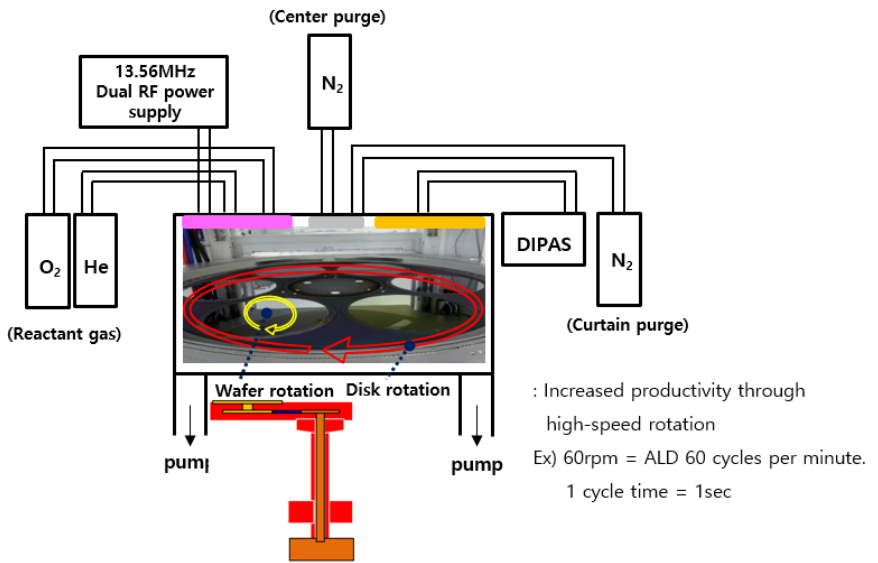
Figure 1. The DED process system